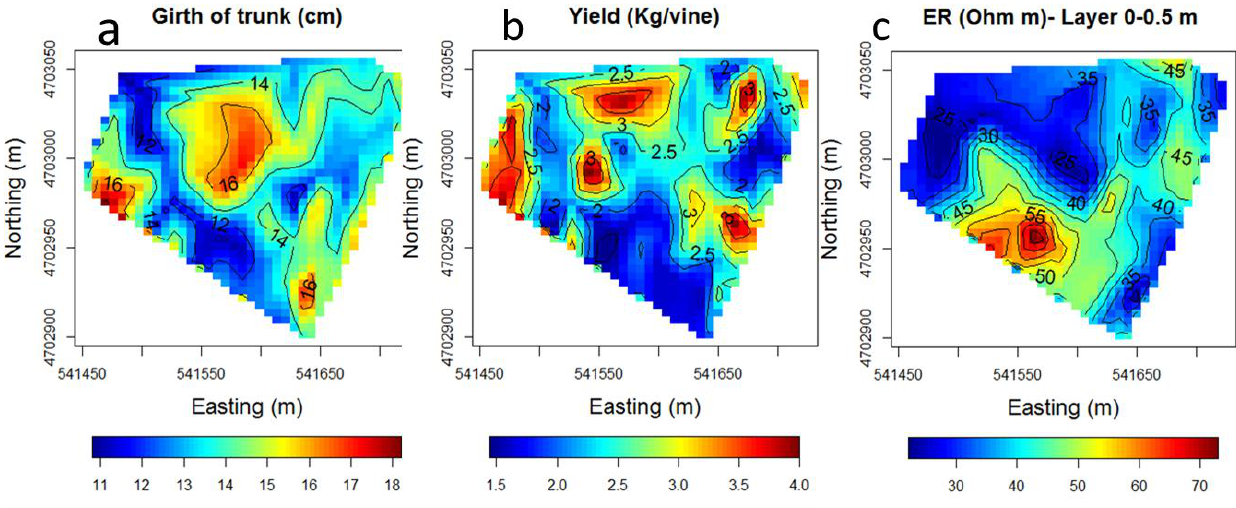
Figure 6. Interpolated maps of ( a ) trunk girth (cm), ( b ) yield (Kg/vine) and ( c ) top-layer (0–0.5 m) soil electrical resistivity